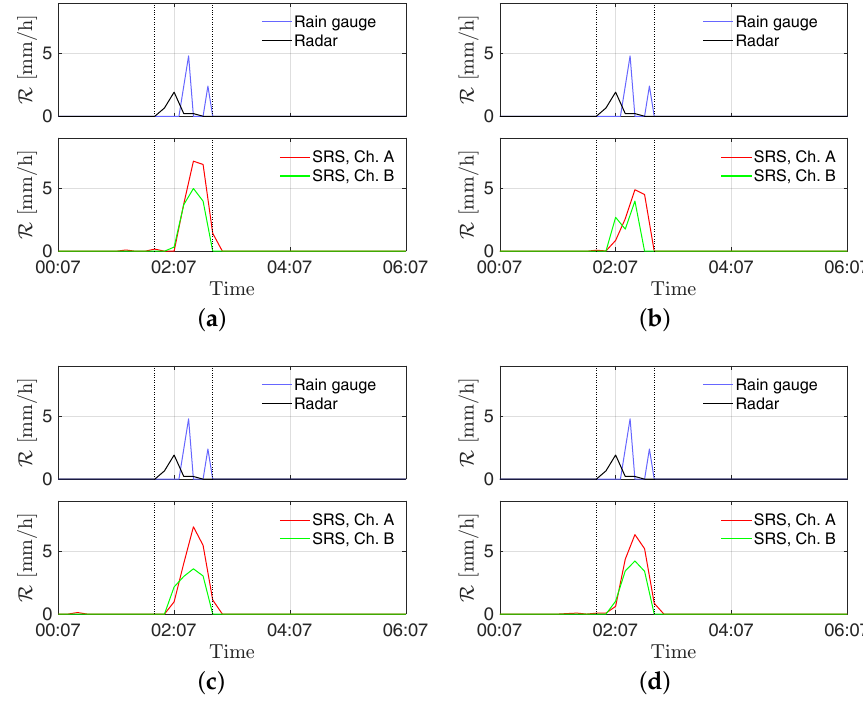
Figure 8. Time series of rainfall intensity R [mm/h] measured at the sites ( a ) S2 − Torcia, ( b ) PZS1, ( c ) Pala Eolica, and ( d ) Uffici Ingr on 4 July 2018. The vertical dotted lines delimit the time window W . Table 2. Mean errors computed inside and outside the rainfall’s temporal windows achieved with the SRS sensors available at the Monte Scarpino landfill on 4 July 2018. Channel Site